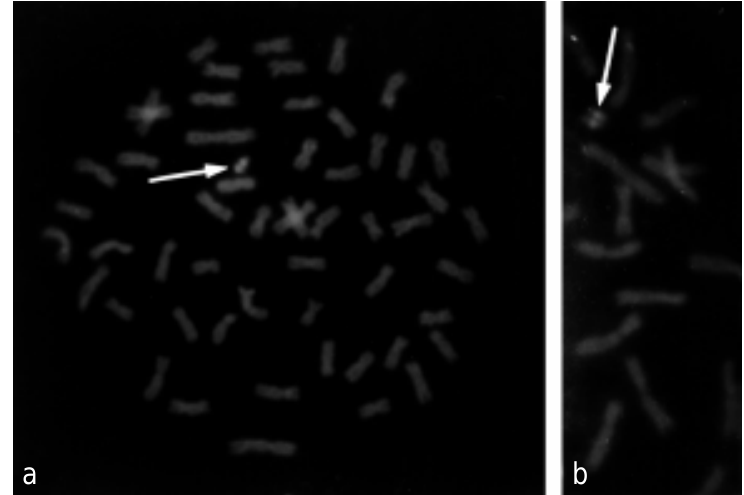
Figure 3 - Completely (a) and partially (b) CMA numerary chromosome with a bright band on the long